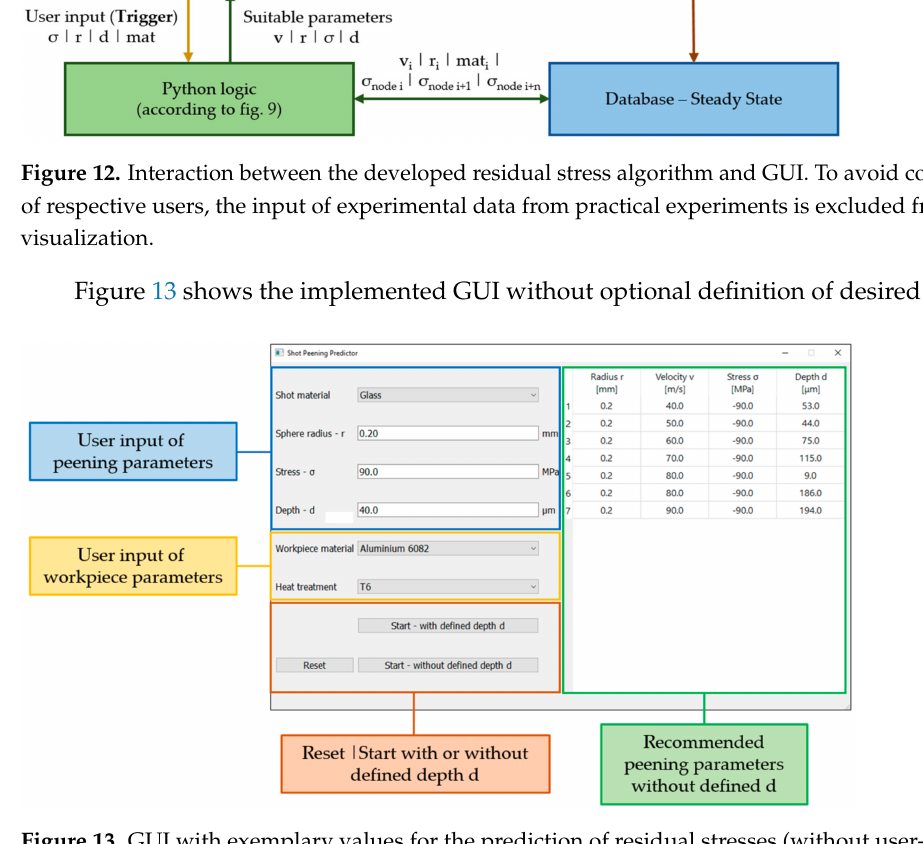
Figure 13. GUI with exemplary values for the prediction of residual stresses (without user-defined stress-corresponding depth).